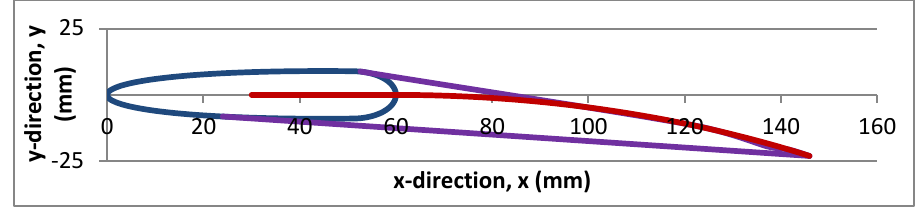
Figure 7. Airfoil cross section at δ = 30°.